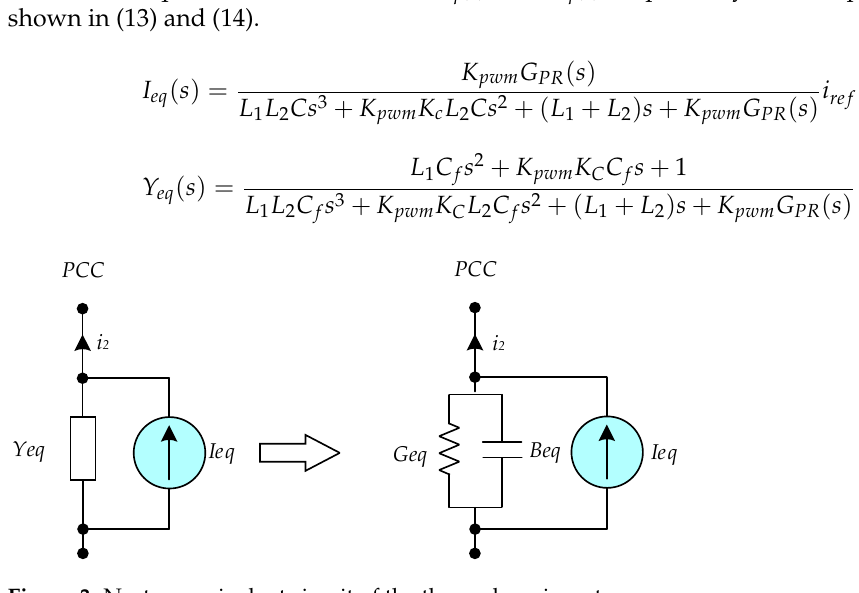
Figure 3. Norton equivalent circuit of the three-phase inverter.